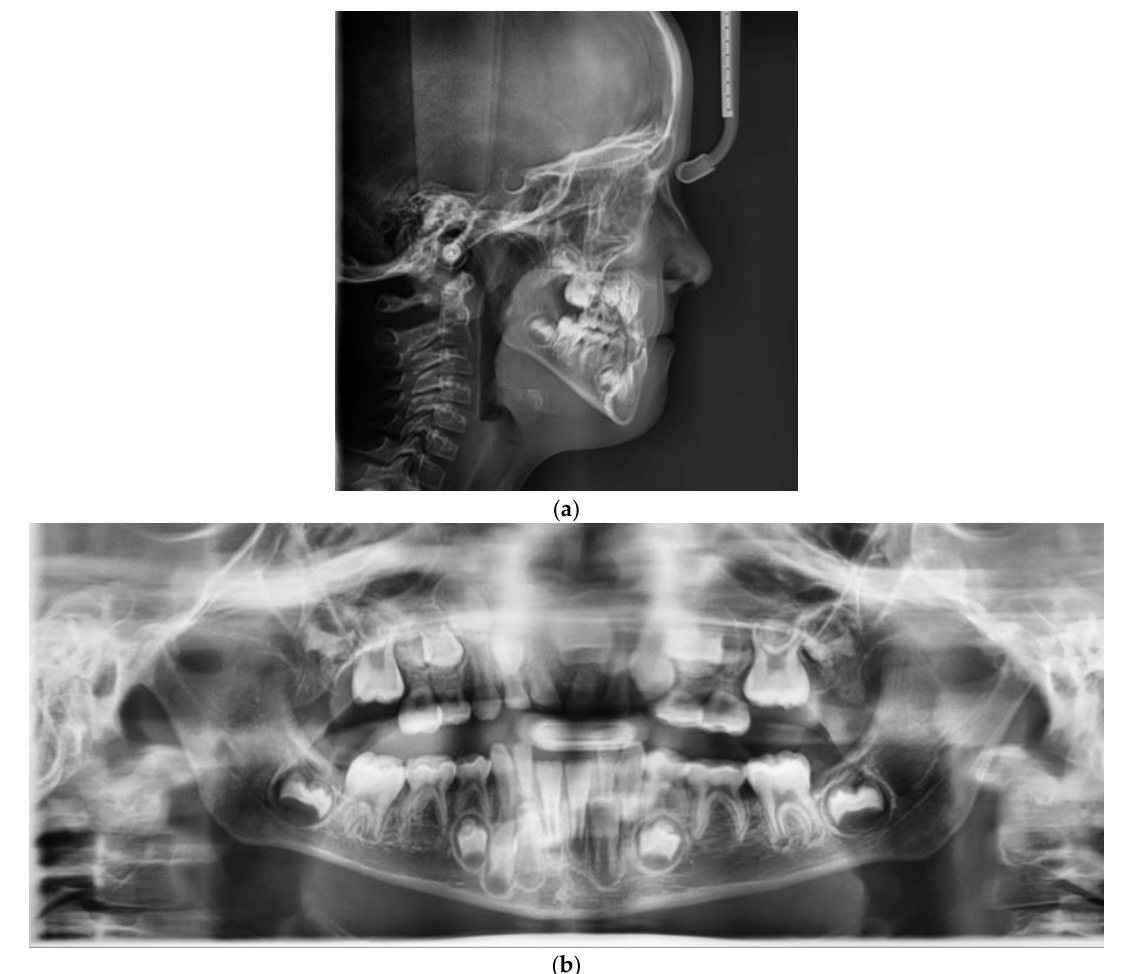
Figure 1. ( a ) Extraoral pre-treatment pictures: lateral and frontal views; ( b ) Intraoral pre-treatment pictures: lateral and frontal views; ( c ) Occlusal views: upper and lower arches.